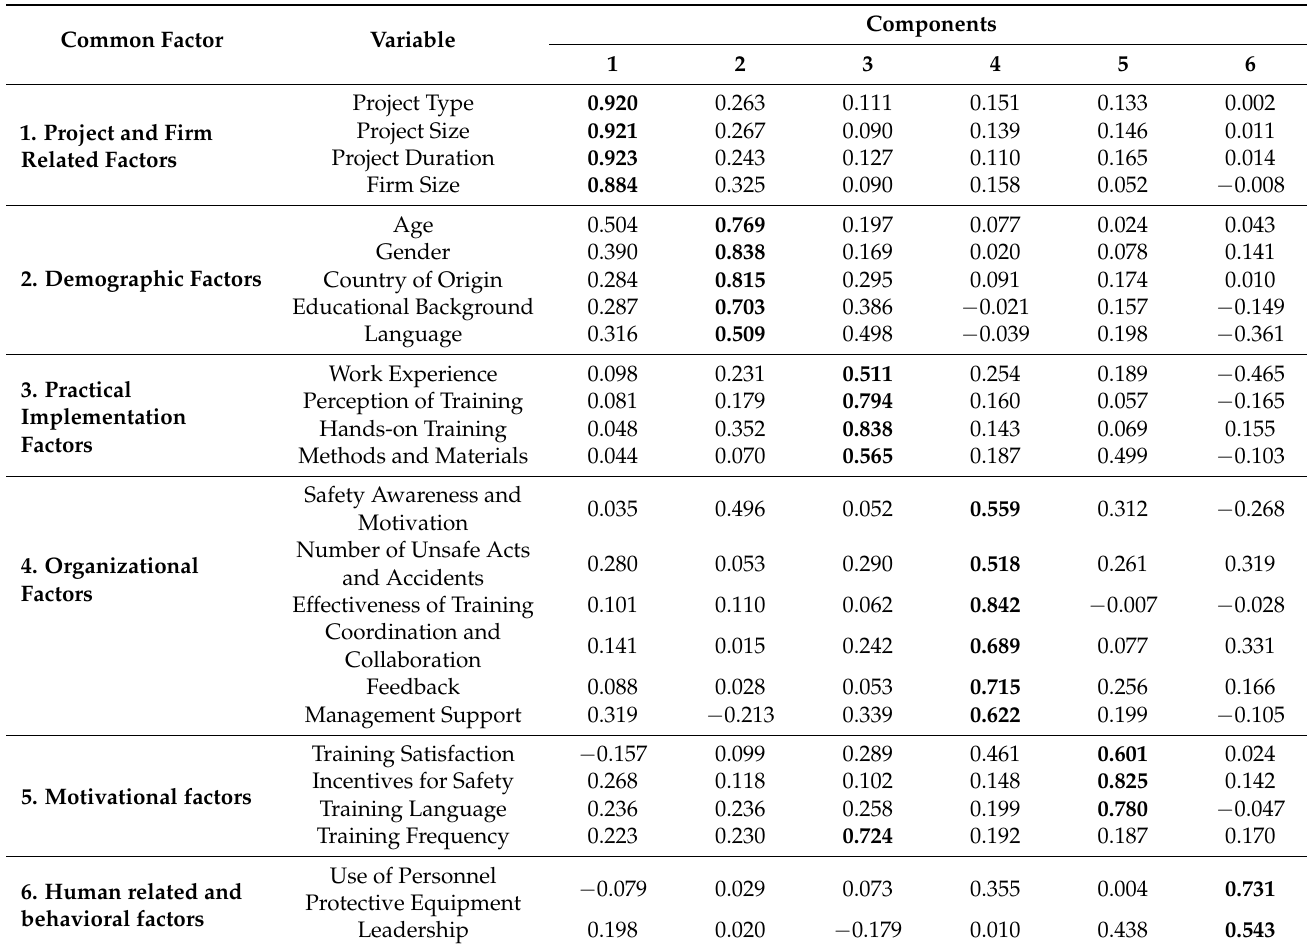
Table 5. Rotated Component